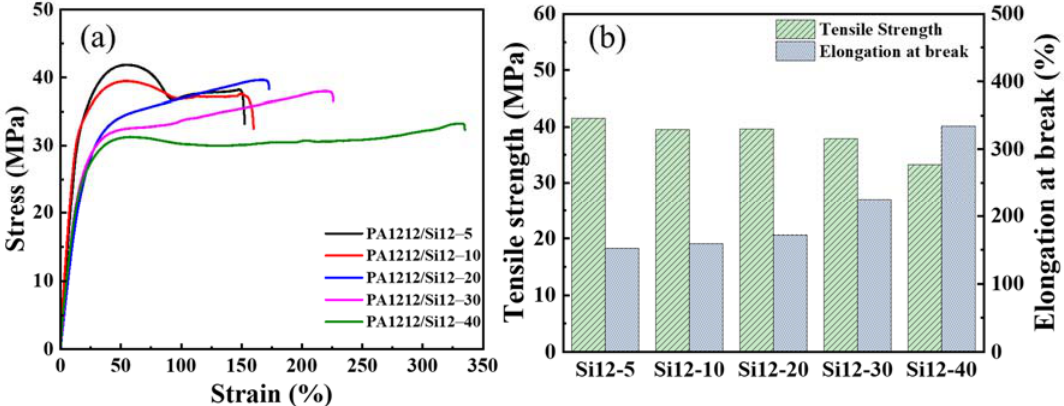
Figure 4. The typical stress–strain curves ( a ) and the tensile strength and elongation at break ( b ) of PA1212/Si12 copolymers.